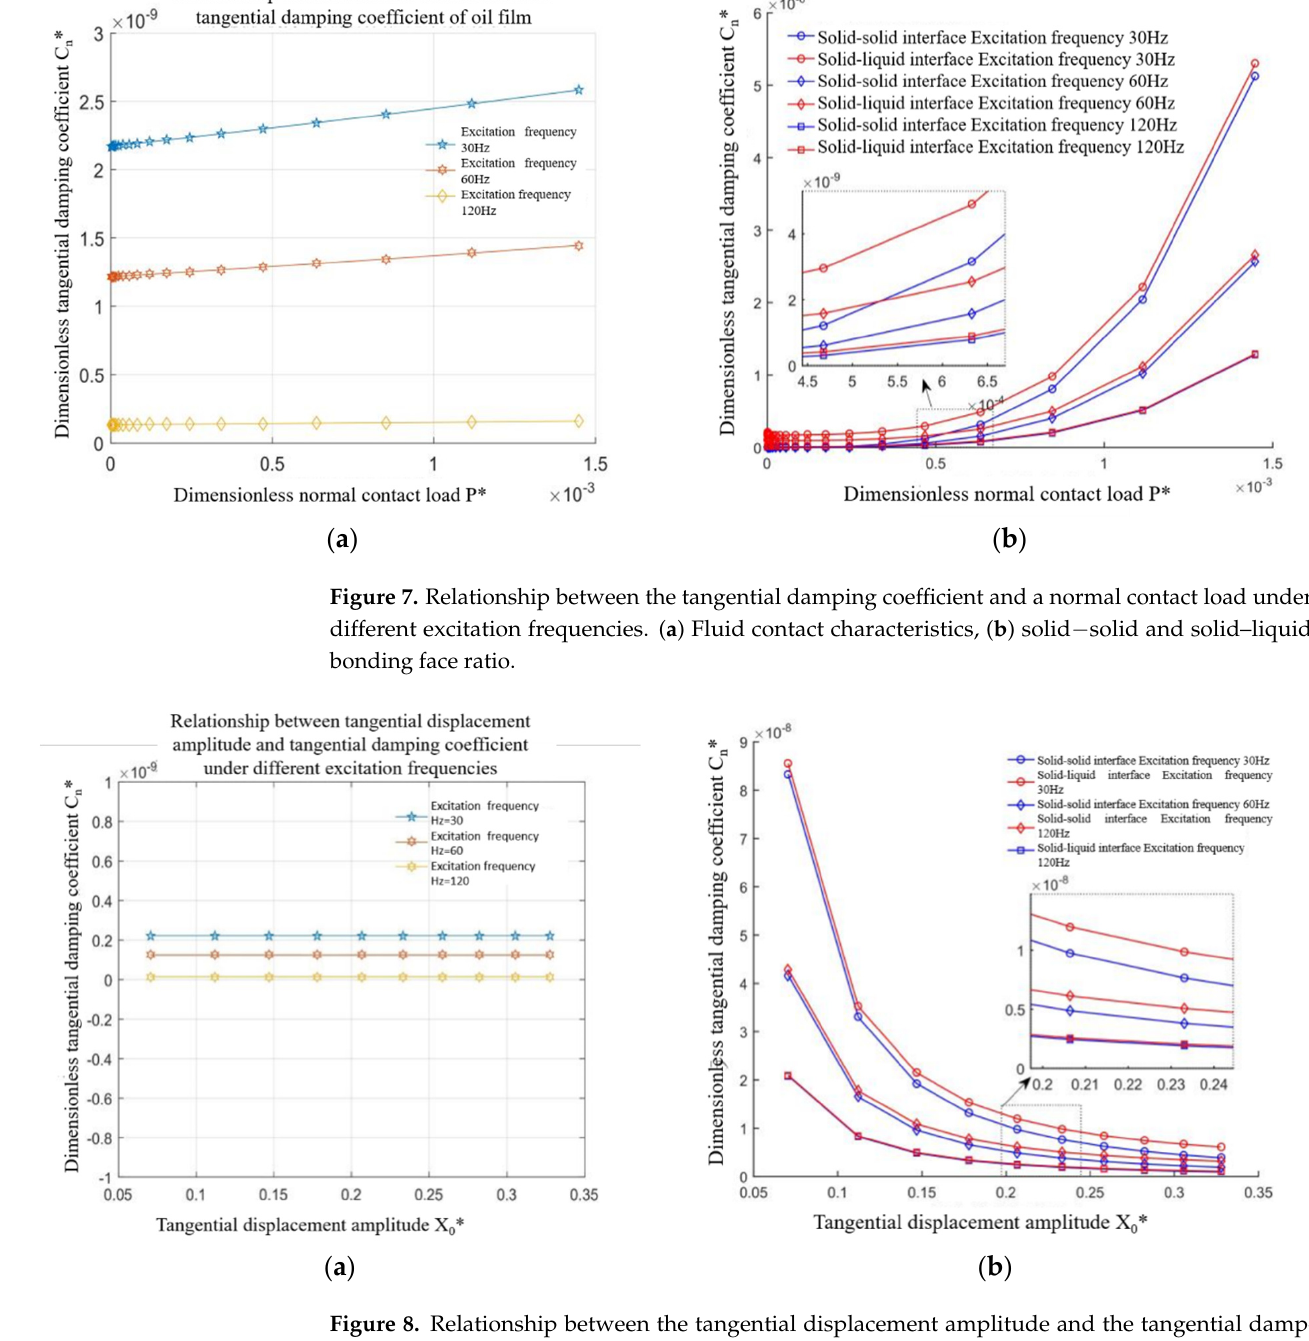
( b ) Figure 9. Relationship between the excitation frequency and the tangential damping coefficient of the solid–solid and solid–liquid interfaces under different tangential displacement amplitudes. ( a ) Fluid contact characteristics, ( b ) solid–solid and solid–liquid bonding face ratio. It can be seen from Figure 9b that the tangential damping of the solid–solid and solid–liquid interfaces decreases nonlinearly with the increase in excitation frequency. From the microscopic point of view of the solid contact, under a given normal load, the increase in the excitation frequency makes the tangential displacement of the microcon- vex body unloaded before it has time to recover, and loaded again, resulting in the in- crease in the maximum tangential displacement and the decrease in energy dissipation. Therefore, the tangential contact damping is reduced. It can be seen from Figure 9a that